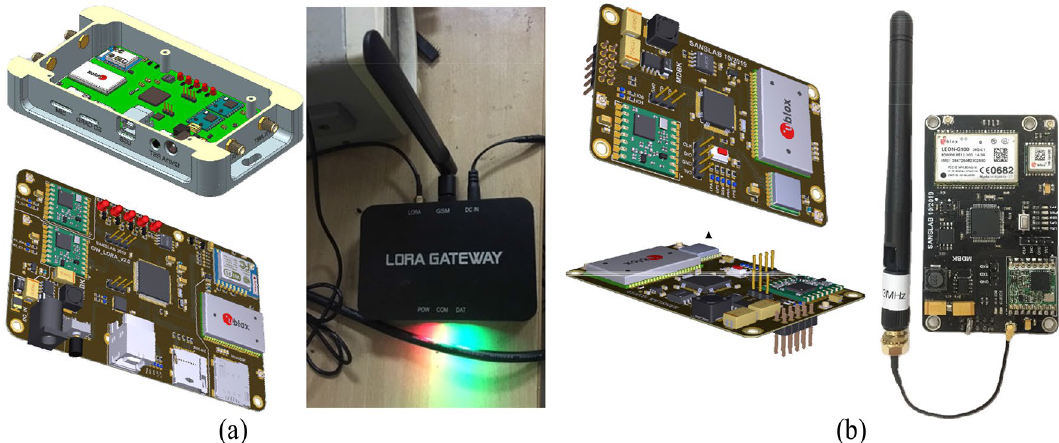
Figure 7. Layouts and prototype images of ( a ) the gateway and ( b ) LoRa, 3G/LTE, and GPS modules equipped for mobile and fixed